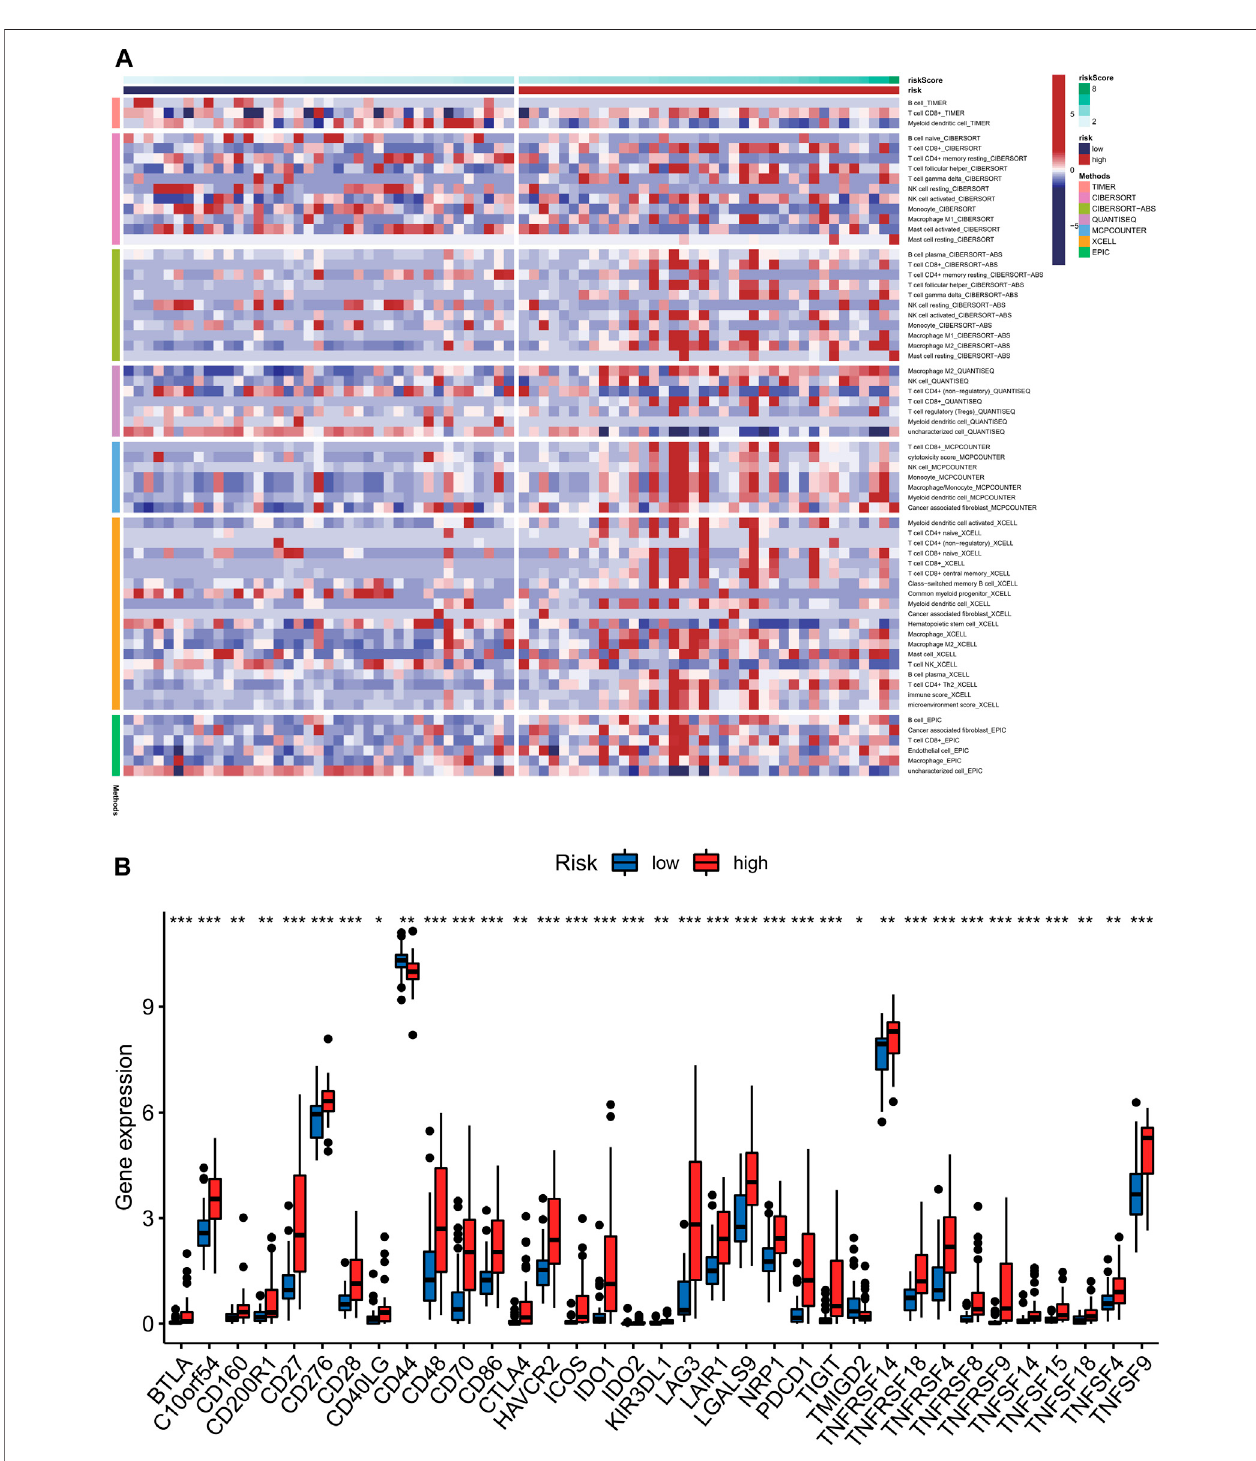
FIGURE 7 | Analysis of immune cell in fi ltration levels correlation analysis of immune checkpoint and in different risk groups. (A) The samples in the training cohort were displayed according to ascending risk scores, while the levels of immune in fi ltration in high-risk and low-risk groups were calculated by algorithm such as TIMER, CIBERSORT, Quantiseq and other methods, which were marked in different colors. The heatmap showed the level of each immune cell in fi ltration in the tumor microenvironmentofthetwogroupsofpatientsunderdifferentalgorithms. (B) Wecouldseethatthehigh-riskgrouptendedtohavehigherlevelsofimmunecellsin the tumor microenvironment. Likewise, The immune checkpoint genes were expressed differently in the twogroups and gene tended to be higher in the high-risk group (*** p < 0.001).